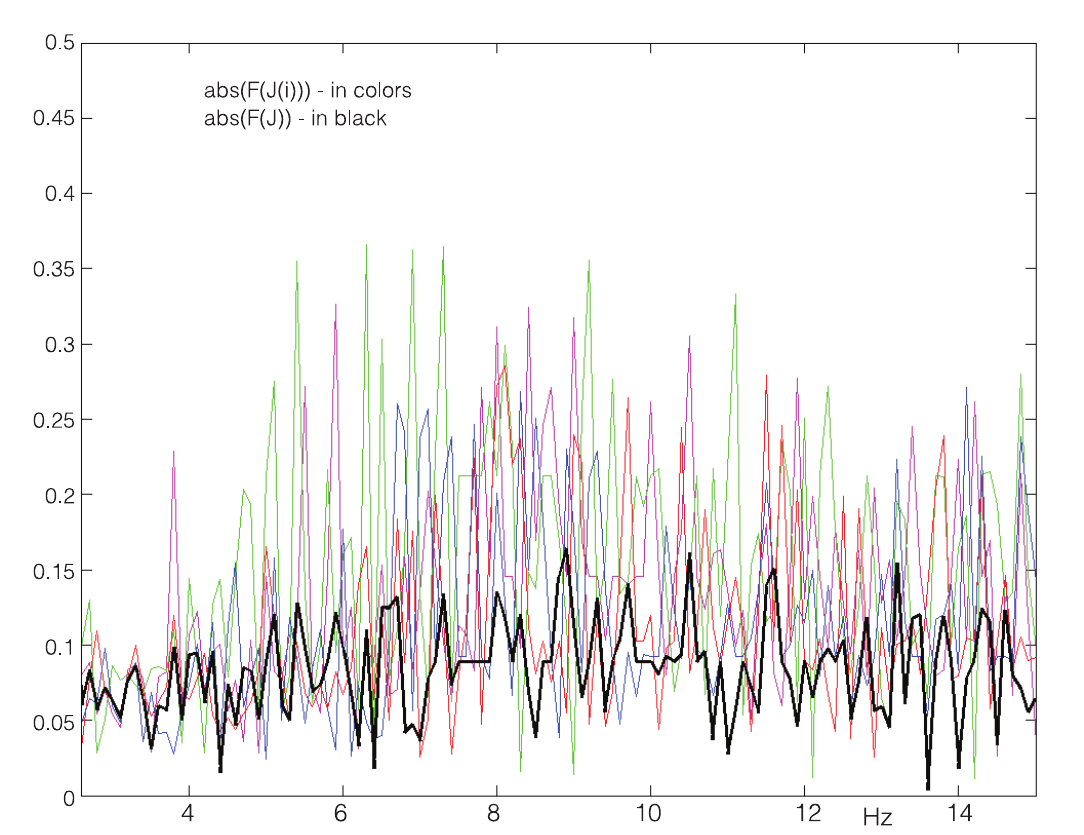
Fig. 4. Examples of the absolute values of the FJ ( i ) functions in the frequency domain computed for the selected time segments (color lines) and the computed mean values (black line) representing function FJ (according to the recordings at L’Aquila Observatory of 16 June 2002 event in the Apennines (22 h 23 min; M =